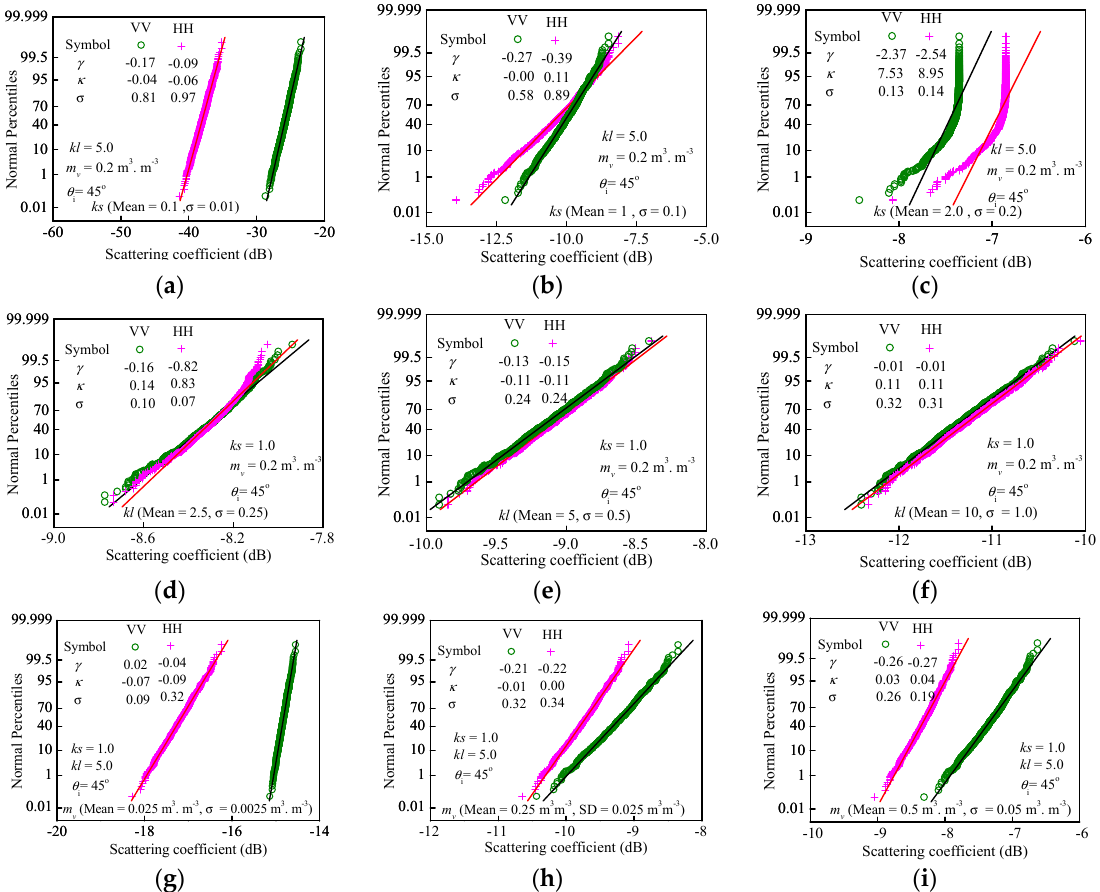
Figure 4. Probability of the scattering coefficient with normal distributed input surface parameters of: ( a – c ) ks ; ( d – f ) kl ; and ( g – i ) m v , at the incident angle of 45 ◦ . The solid line is the reference line for a normal distribution fit. ( a , d , g ) Small ks , kl , and m v ; ( b , e , h ) medium ks , kl , and m v ; and ( c , f , i ) large . The parameters on upper left of the figures show the distribution of the scattering coefficients, while on the bottom are the input parameters.